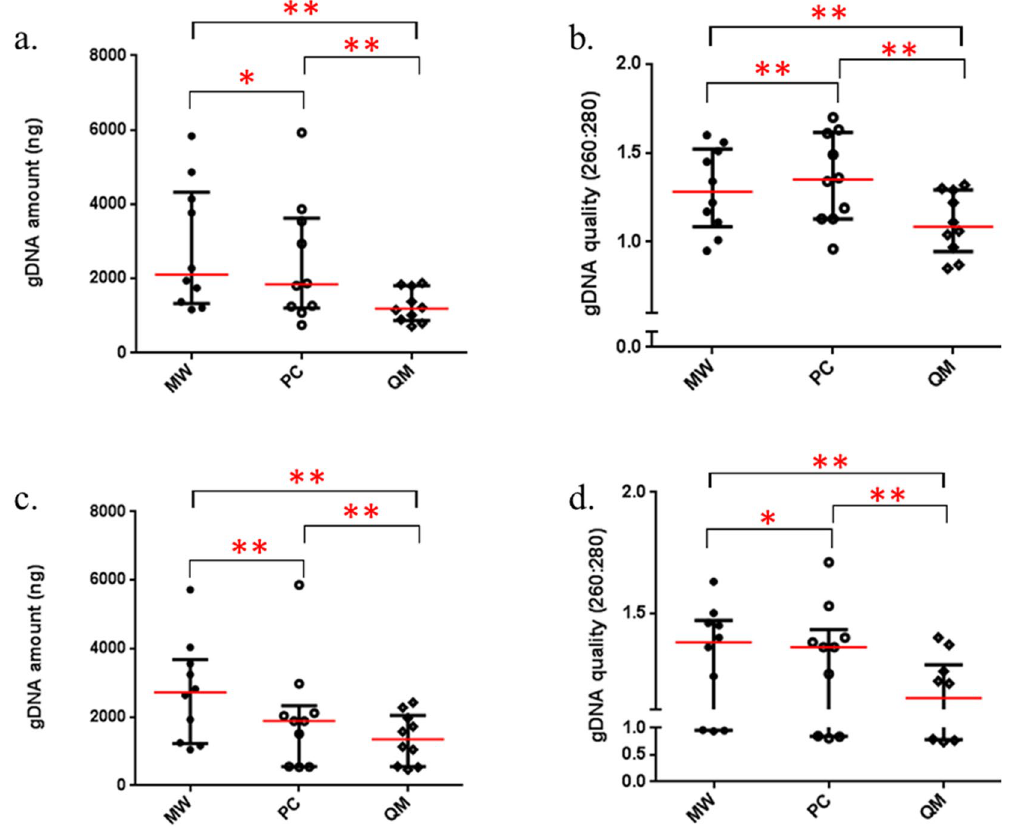
Figure 3. Extracted salivary gDNA from different bacterial gDNA extraction methods. Scatter plots for the average quantity and quality of the extracted gDNA triplicates from each collection (a., b. spit from 50 mL Falcon tube and c., d. OMNIgene) and extraction (MW represents Maxwell ® 16 LEV blood DNA kit; PC represents in-house phenol-chloroform extraction and QM represents QIAamp DNA Microbiome Kit) method. Significant differences are denoted with * = p < 0.05, ** p = < 0.01, *** = p < 0.001, **** = p < 0.0001 respectively.